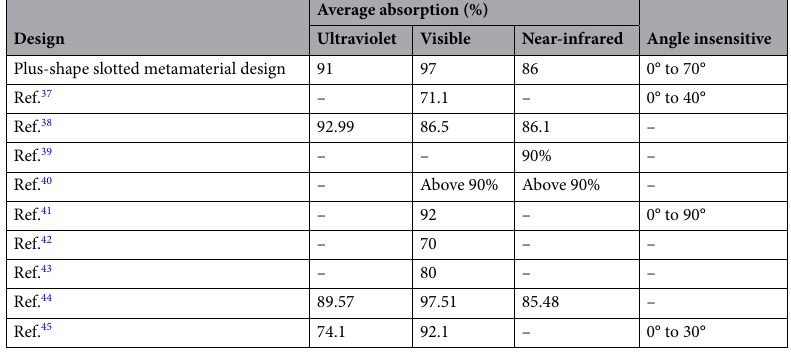
Table 1. Comparison of the developed solar absorber with the available